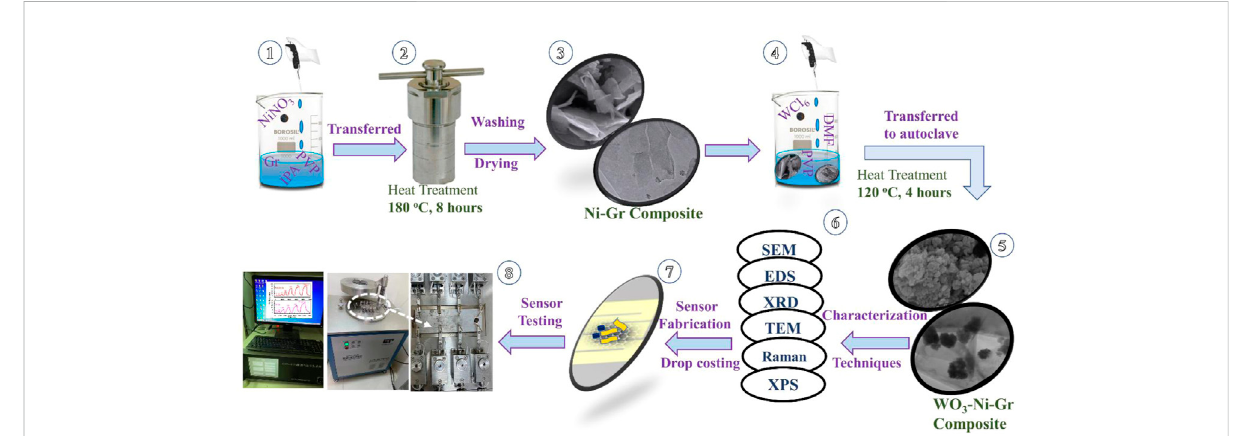
FIGURE 1 Schematic of the syntheses of Ni-Gr and WO 3 -Ni-Gr composites, sensor fabrication, and